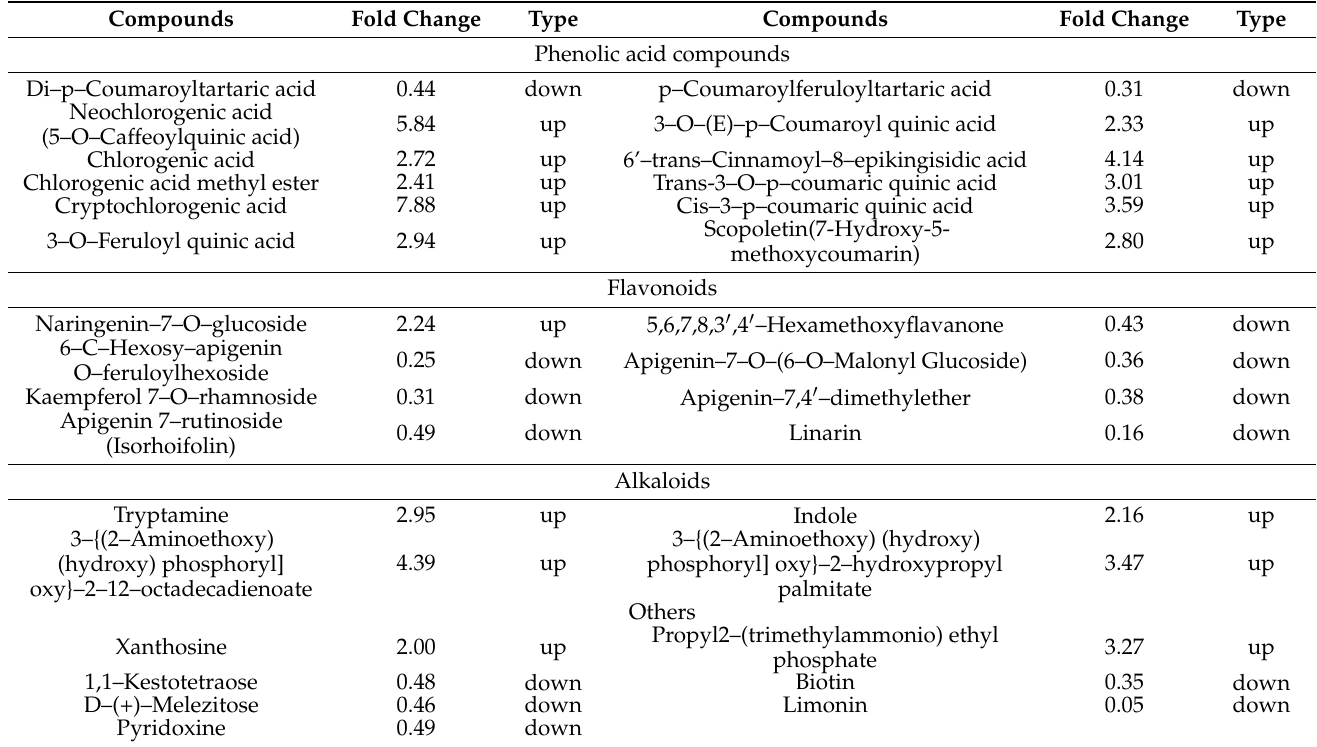
Table 3. Representative differential secondary